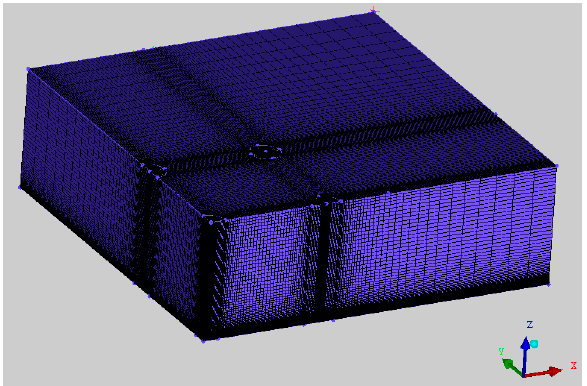
Figure 6. Geometric model for 3D case.